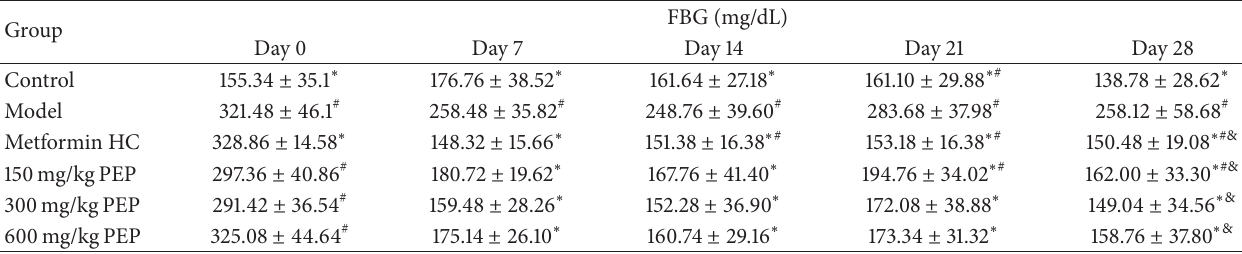
Table 2: The effect of PEP on FBG levels in DM rats.